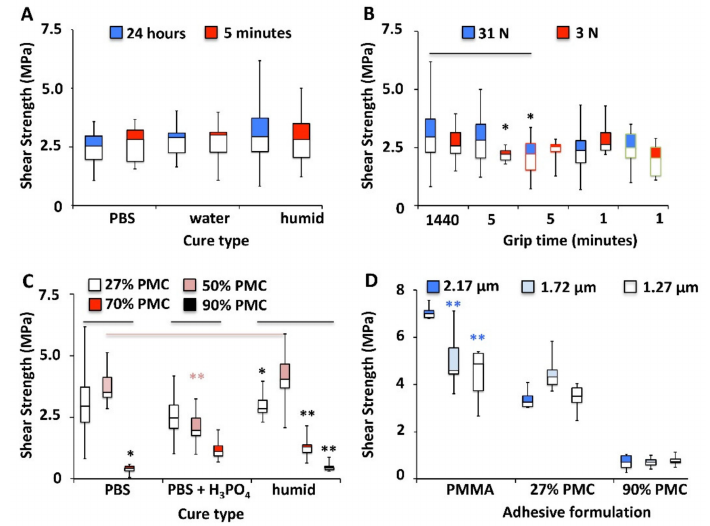
Figure 3. Adhesive strength of PMC in varied preparation / application, and the cure conditions. ( A ) Di ff erent curing environments (phosphate-bu ff ered saline (PBS), water, or 100% humidity) and grip duration (24 h, blue box; or 5 min, red box) before curing did not a ff ect the adhesive strength of 27% PMC (from left to right: groups #1, 4, 2, 5, 3, 6). ( B ) When the grip duration was shortened and the grip force reduced to mimic clinical conditions, comparable adhesive strength was observed in all samples except the automated mixing sample (red border) and low grip force (3 N) samples gripped for 5 min (from left to right: groups #3, 9, 6, 10, 7, 11, 8, 12, 33, 34; the red border indicates high speed mixing; green border indicates bone samples). ( C ) Di ff erent mole ratios of phosphoserine to α TCP, and cure conditions, a ff ected adhesive strengths (from left to right: groups #3, 14, 15; 19–21; 13, 16–18) (100% humidity samples were gripped for 1 min). ( D ) Adhesive strength of PMMA, 27%, or 90% PMC, to aluminum cubes with di ff erent surface roughness (gripped 1 min). All samples were prepared by hand mixing, gripped (31 N) for 24 h in PBS, using 27% PMC, unless otherwise indicated. Box plots represent the mean (midline), 75th (top box), and 25th percentile (bottom box), while whiskers represent the highest and lowest values in each group. Statistical comparisons made in 3C between di ff erent formulations, with an identical cure condition, are indicated by black brackets; while comparisons made between di ff erent cure conditions with identical formulation are indicated by colored brackets matching the group color in the legend (e.g., 70% PMC compared between PBS vs. PBS + H3PO4 vs. humid, pink bracket). In Figure 3C, within each cure condition, comparisons were made between the mean of 50% PMC and all other formulations. Comparison between group means were conducted with ANOVA (Tukey or Games-Howell post hoc analysis, for samples with homogeneous, or inhomogeneous variance), with * indicating p-values below 0.05, and ** indicating p-value below